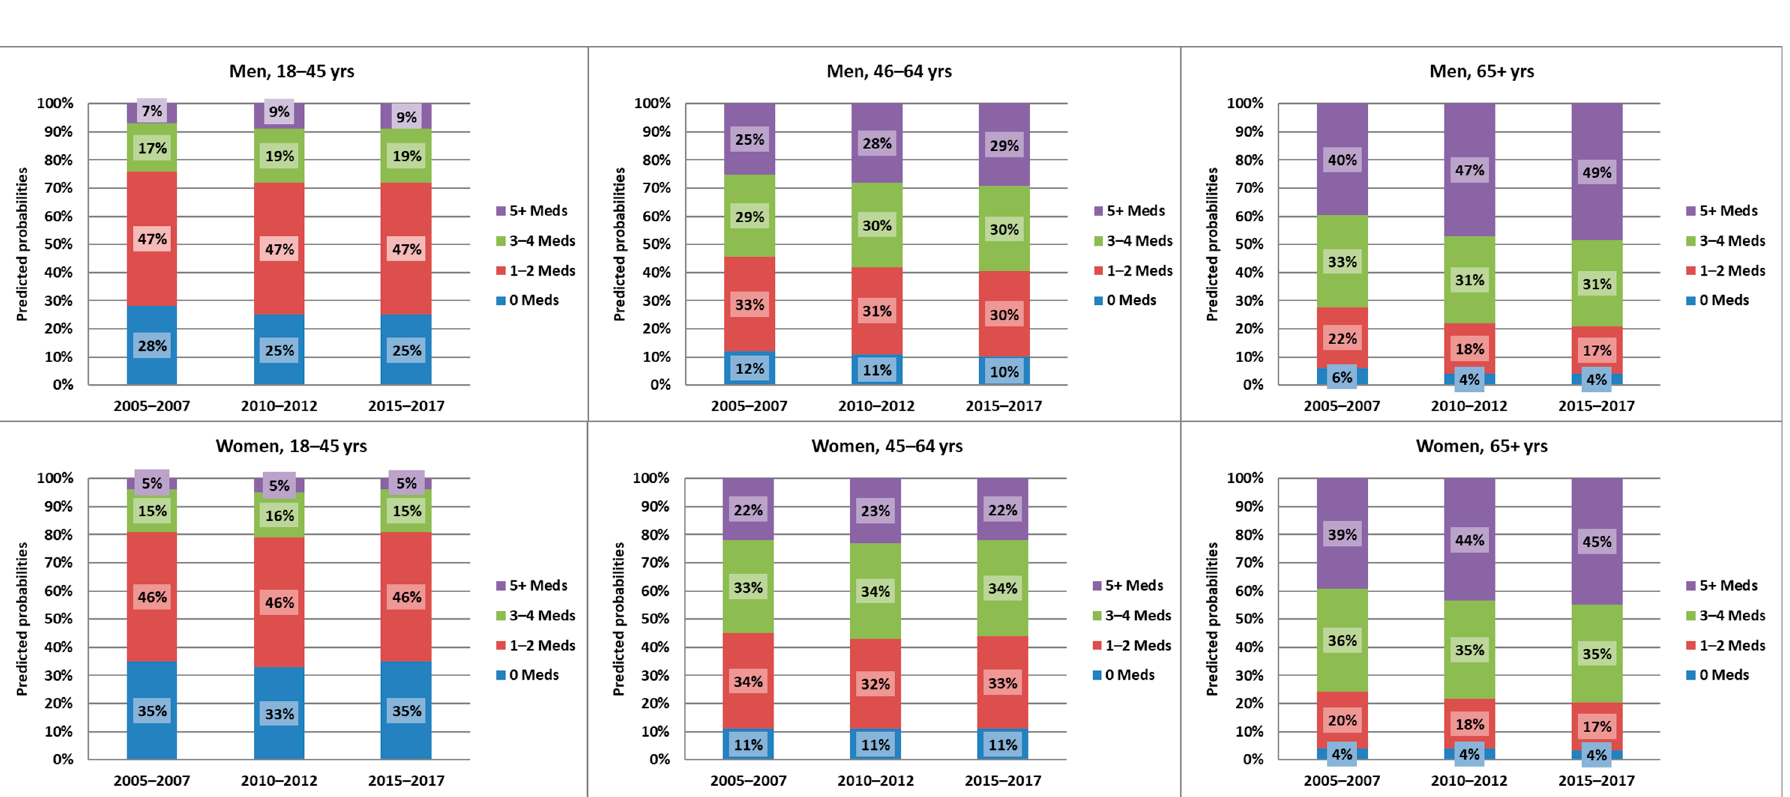
Figure 1. Predicted probabilities of the number of discrete prescribed medications per individual over the three time periods, stratified by gender and three age groups. Meds = Medications.